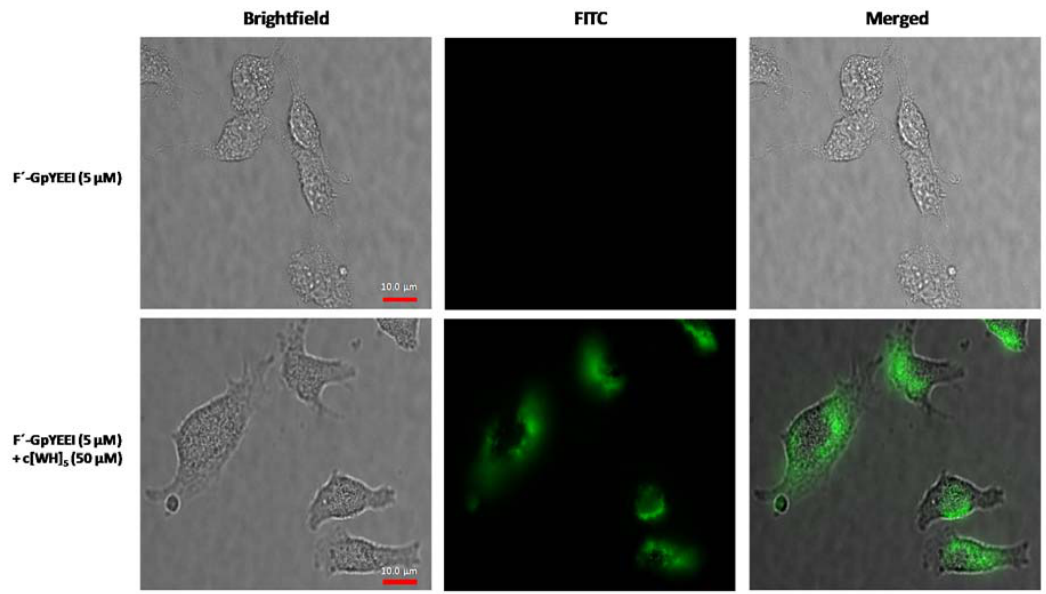
Figure 5. Microscope images of F’ ‐ GpYEEI uptake by SK ‐ OV ‐ 3 cells in the presence of cyclic [WH] 5 after 3 h incubation. No green fluorescence was observed in the presence of F’ ‐ GpYEEI alone. FITC: Fluorescein isothiocyanate.